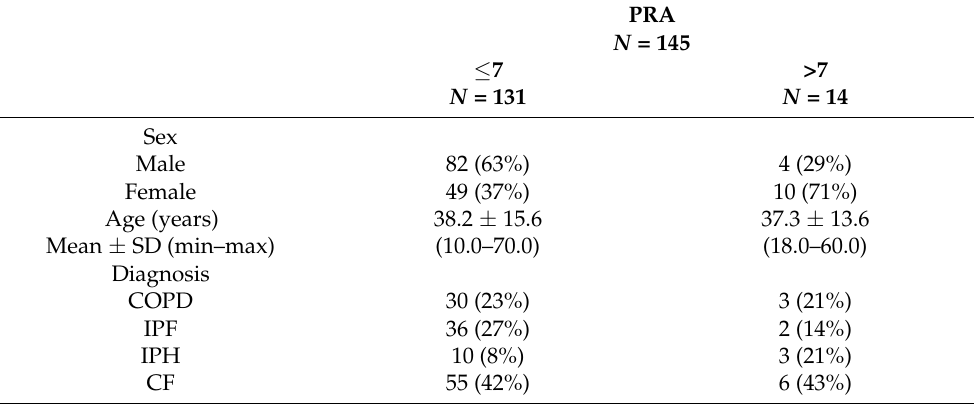
Table 1. Characteristics of the study group depending on the degree of immunization based on the PRA results.